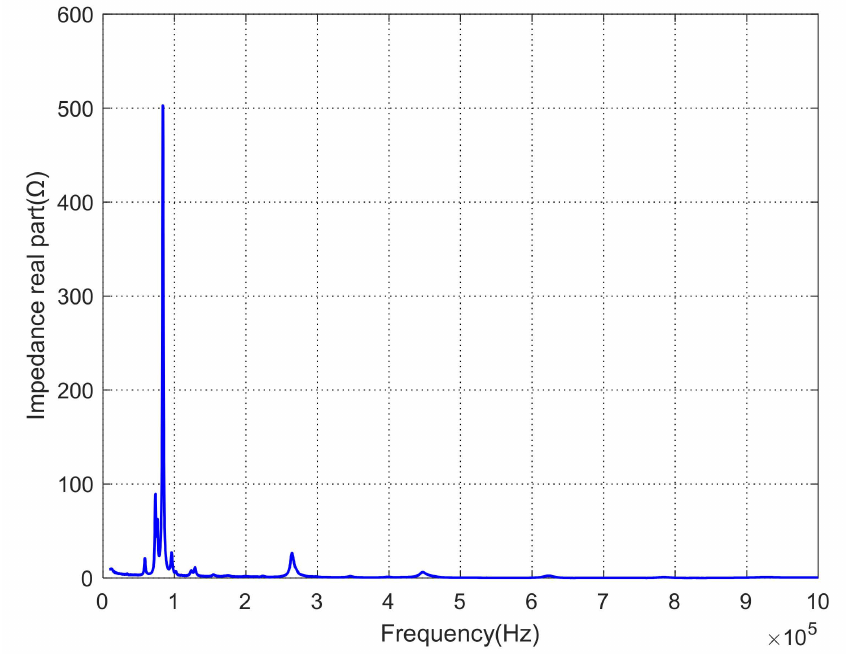
Figure 10. 10 kHz–1 MHz conductivity